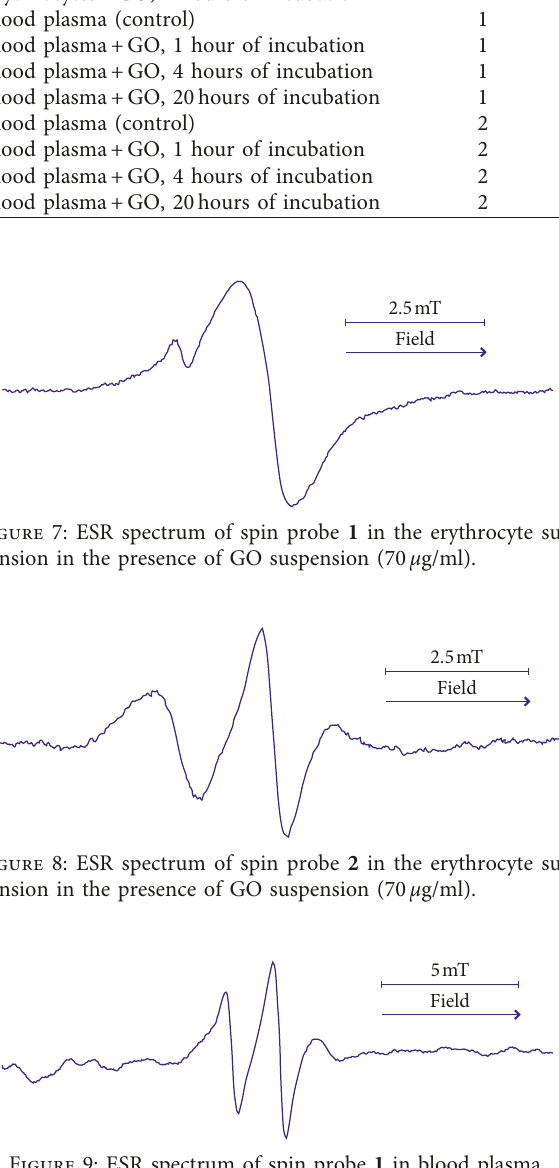
Figure 9: ESR spectrum of spin probe 1 in blood plasma.